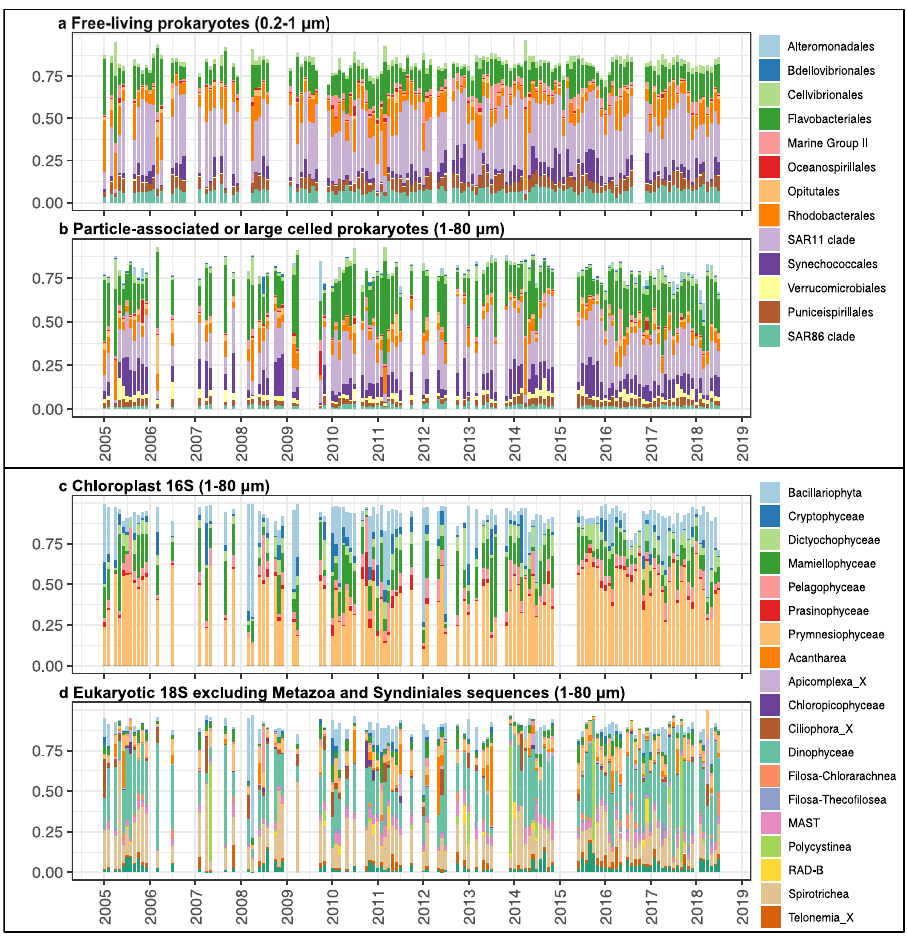
Fig. 2 | Temporal variation of the entire community composition at the SPOT location. Order level taxonomic composition of ( a ) free-living prokaryotes (0.2 – 1 μ m), ( b ) particle-associated or large-celled (1 – 80 μ m) prokaryotes, ( c ) chloroplast 16S (representing phototrophic eukaryotes), and ( d ) eukaryotic 18S